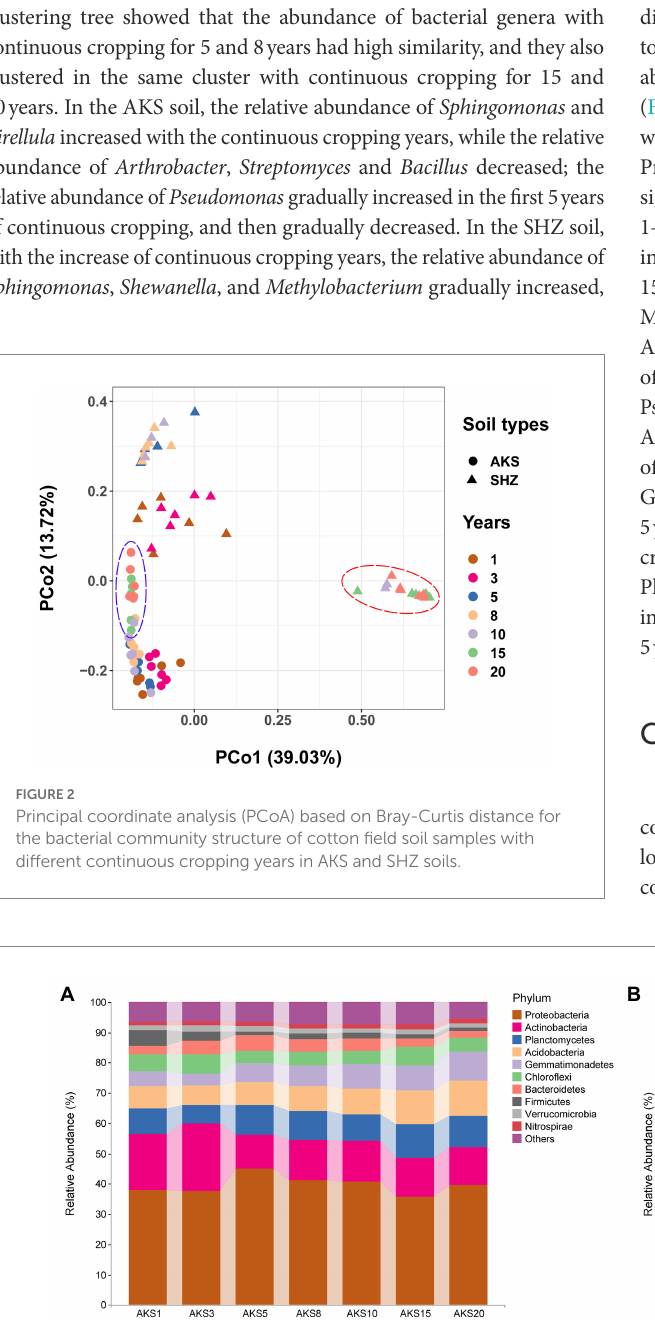
FIGURE 3 The relative abundance of the top 10 bacterial phyla in cotton field soil samples with different continuous cropping years in AKS (A) and SHZ (B)